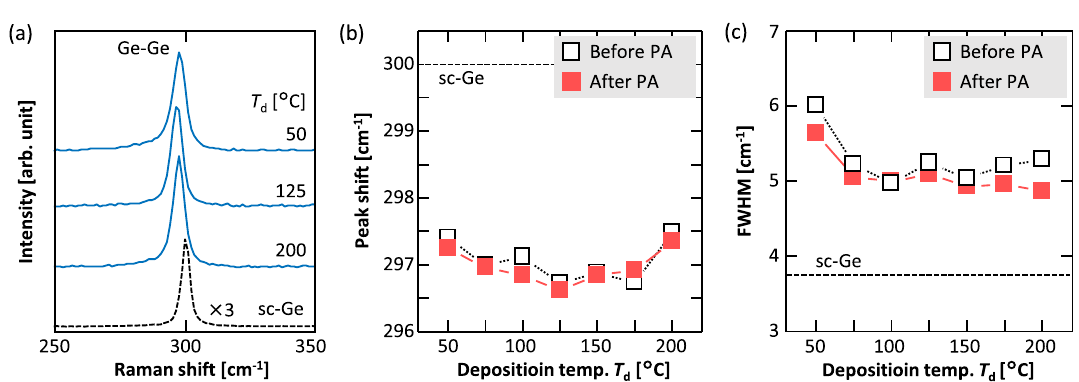
Figure 2. Raman spectroscopy study of the Ge layers. ( a ) Raman spectra of the samples before PA. ( b ) Raman shifts and ( c ) FWHMs of the Ge peaks of the samples before and after PA as functions of T d . The data for a bulk sc-Ge wafer are shown by the dotted